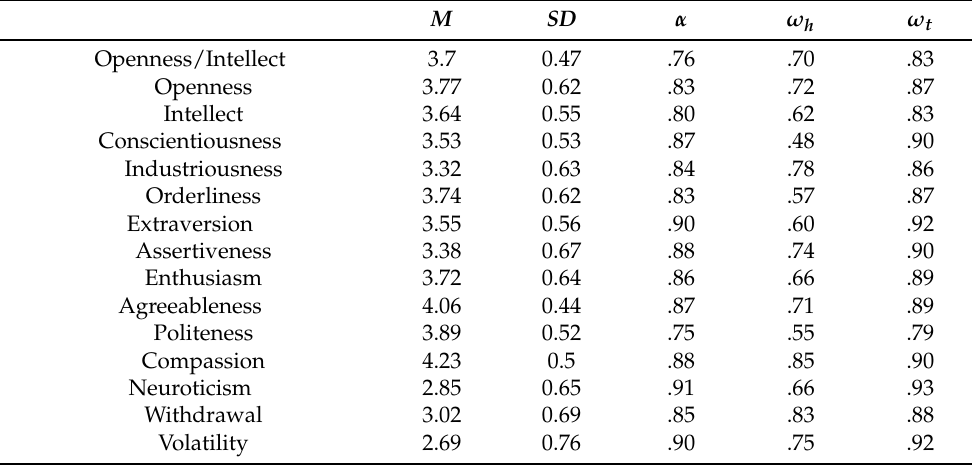
Table 1. Descriptive statistics and reliability measures for the Big Five Aspect Scale.